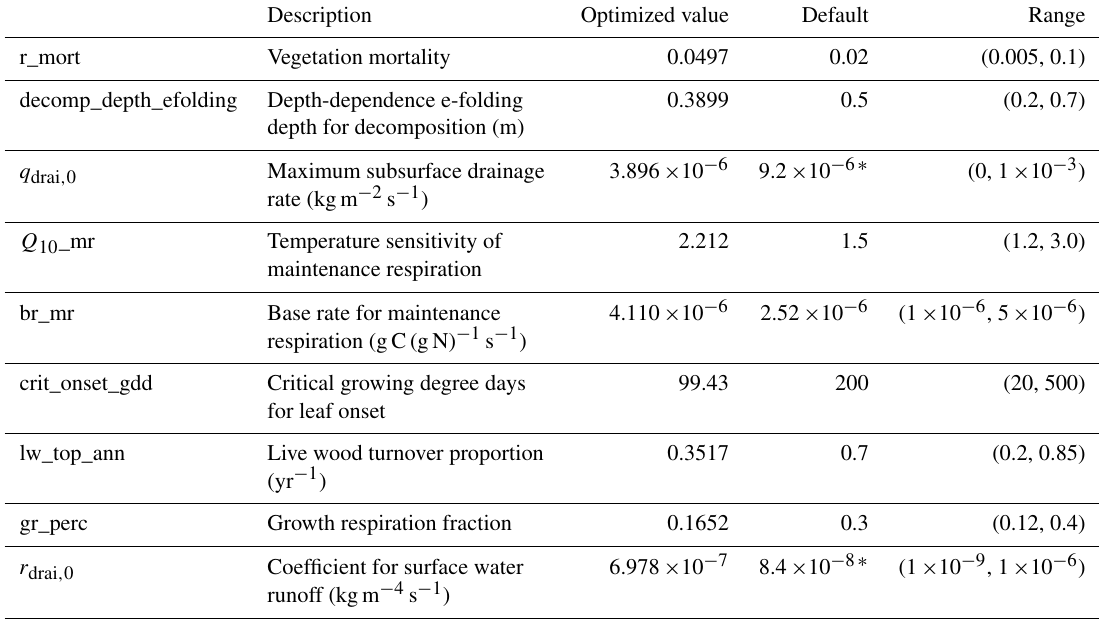
Table 3. Non-PFT-specific optimized model